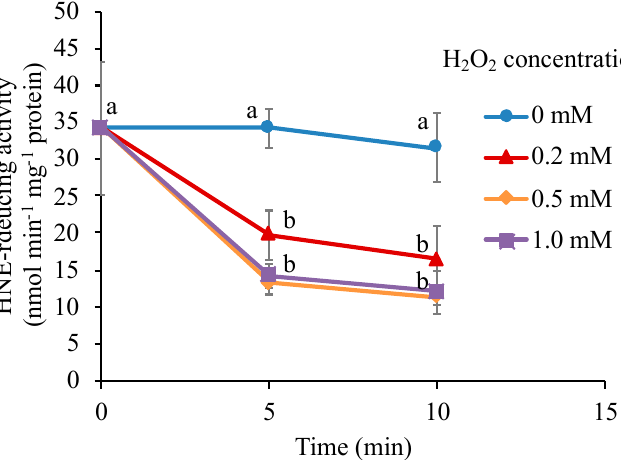
Figure 8. Effect of H 2 O 2 on the NADPH-dependent HNE-reducing activity in protein extract from BY-2 cells. Proteins were extracted from untreated cells. H 2 O 2 was added at the indicated concentration to the protein extract in the presence of 0.5 mM NH 2 OH. The HNE-reducing activity was determined at the indicated time after addition of H 2 O 2 , as in the Materials and Methods section. Different letters among the treatments represent significantly different values ( p < 0.05 on Tukey test).